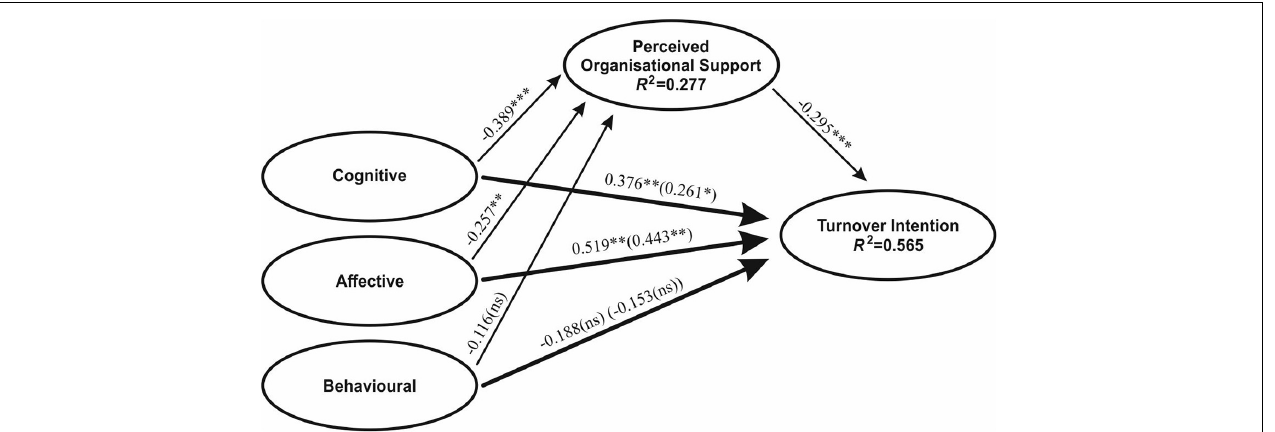
FIGURE 2 | Proposed research model. *** p < 0.001, ** p < 0.01, *p < 0.05; ns, not significant, parenthetical = after adding mediating variable